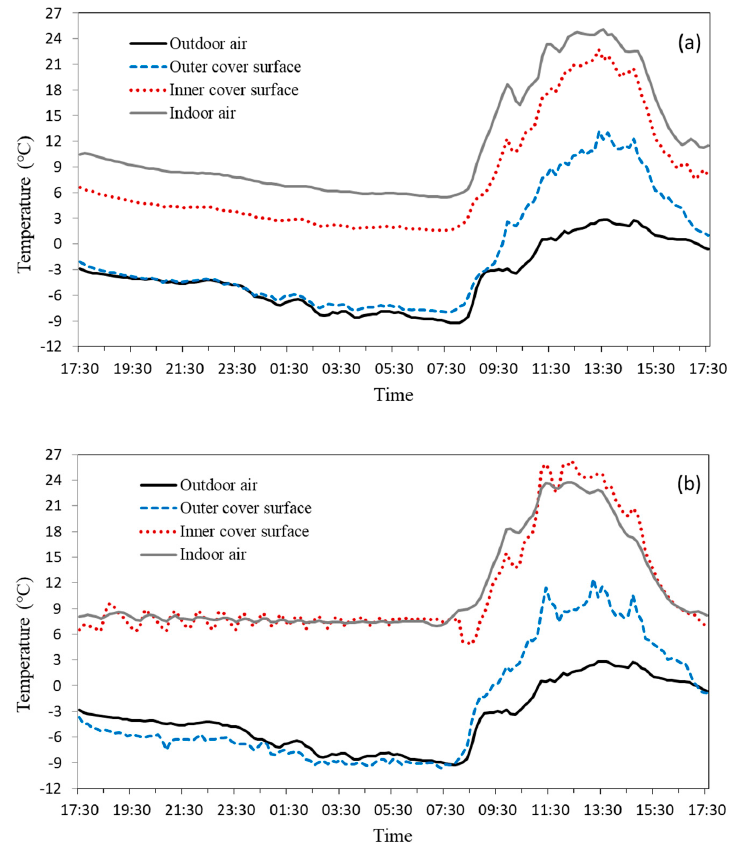
Figure 4. Variations in outdoor air, outer cover surface, inner cover surface, and indoor air temperature on a sunny day (19–20 January 2016) ( a ) without thermal curtains and ( b ) with thermal curtains.